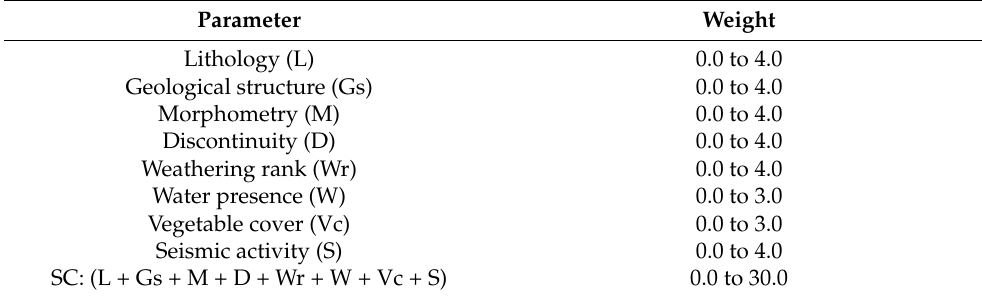
Table 4. Main parameters and weights assigned to rock mass in the susceptibility coefficient estima- tion, based on